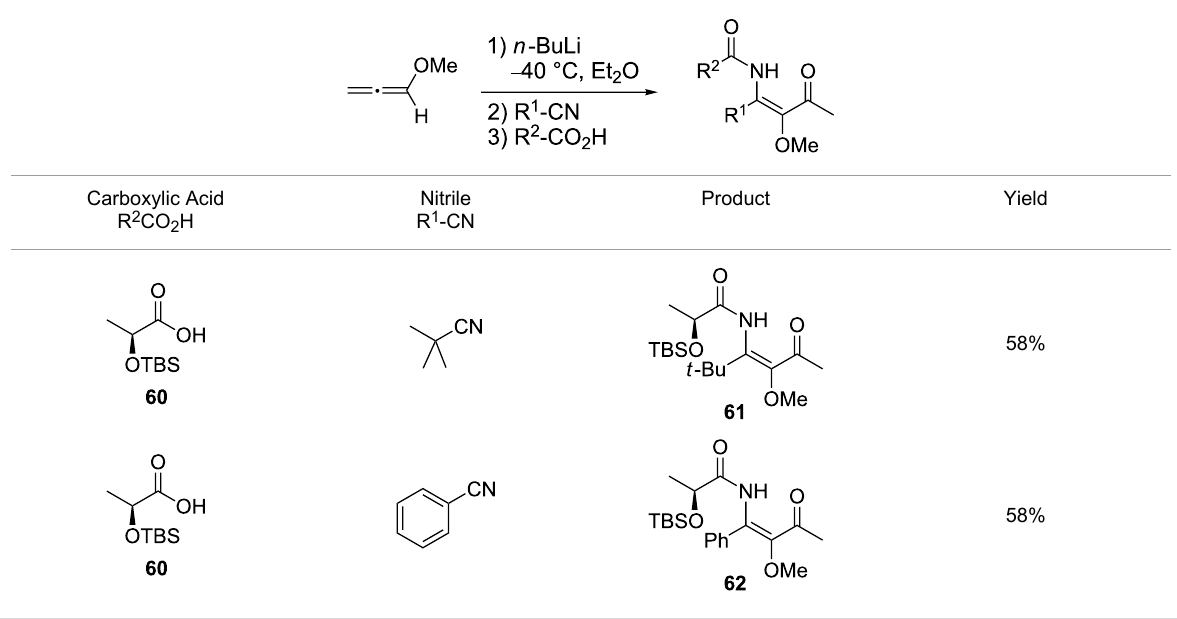
Table 3: Scope of the synthesis of β -alkoxy- β -ketoenamides derived from lactic acid based